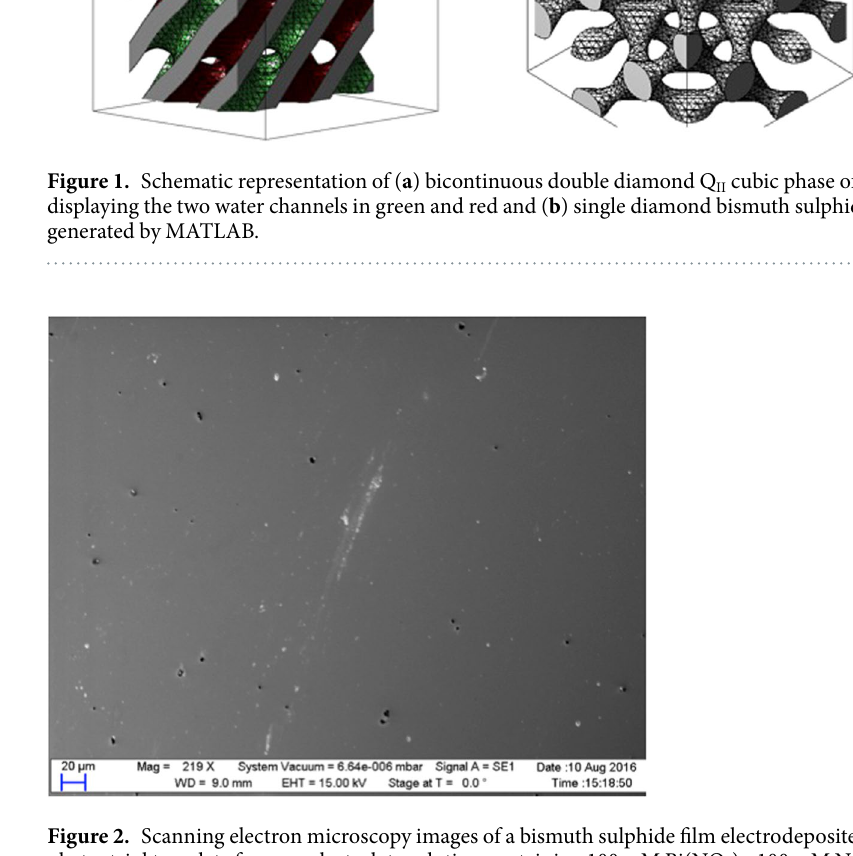
Figure 2. Scanning electron microscopy images of a bismuth sulphide film electrodeposited through a phytantriol template from an electrolyte solution containing 100 mM Bi(NO 3 ) 3 , 100 mM Na 2 S 2 O 3 and 200 mM EDTA in deionised water. The film was deposited potentiostatically at a potential of − 0.4 V vs. SCE for 4